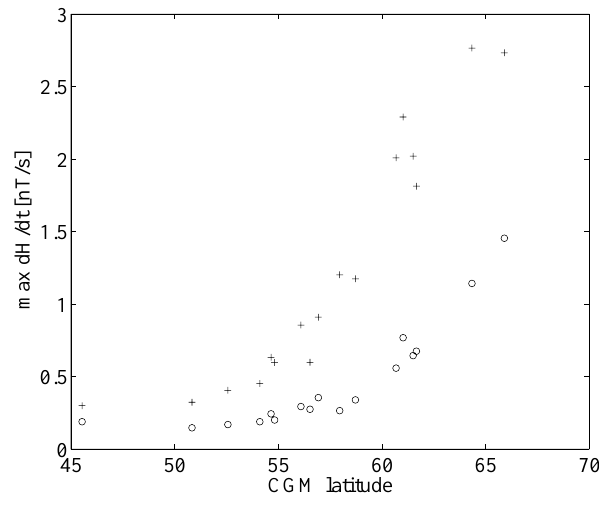
Fig. 2. The mean max | d H /dt | at each SAMNET station against the corrected geomagnetic latitude. The crosses are storm time sub- storm onsets (83 events), and circles are the non-storm time onsets (470